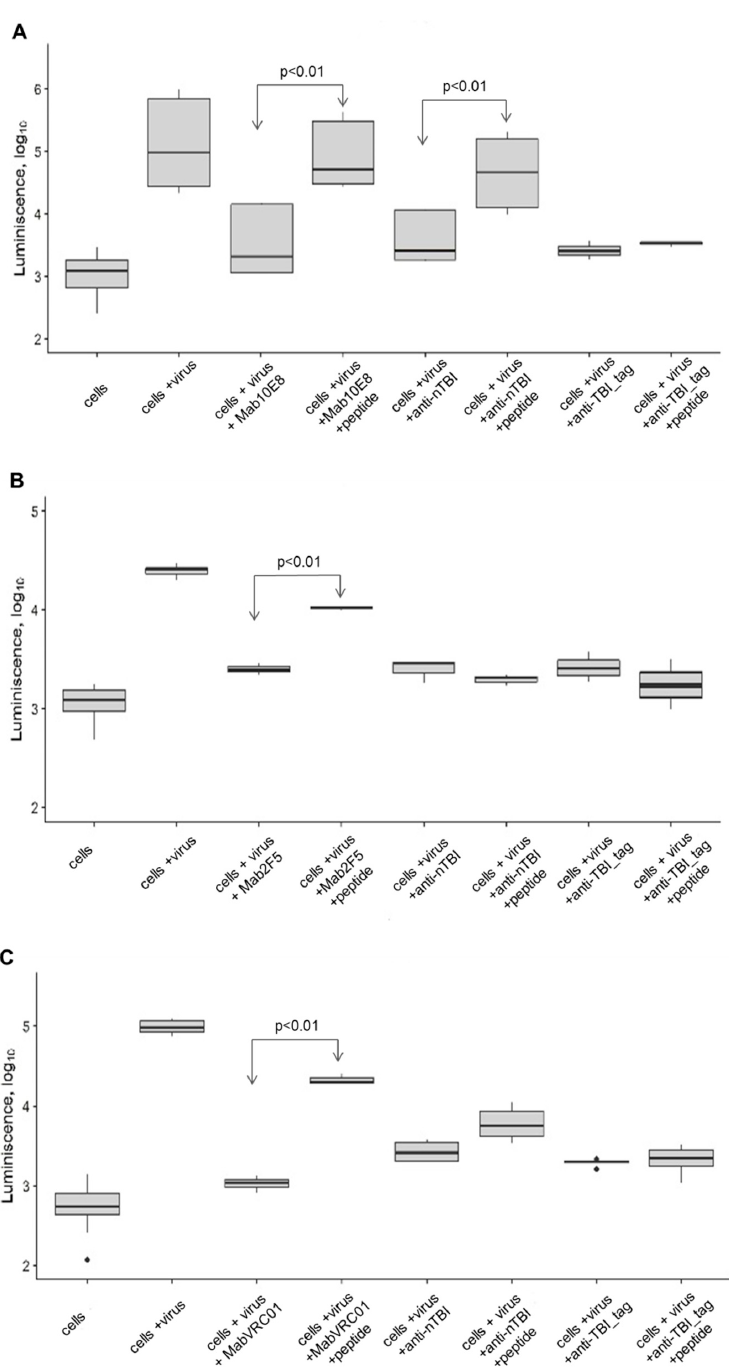
Figure 7. Inhibition of virus-neutralizing activity of antibodies by synthesized peptides: ( A ) 10E8 [NWFNITNWLWYIK], ( B ) 2F5 [NEQELLELDKWASLWNK], ( C ) VRC01 [VSWPELYKWTWS]. The following combinations were tested in the assay: cell + virus; cell + virus + monoclonal mAb 10E8 or 2F5, or VRC01; cell + virus + monoclonal mAb 10E8 or 2F5, or VRC01 + corresponding synthetic peptide; cell + virus + anti-nTBI IgG; cell + virus + anti-nTBI IgG + synthetic peptide; cell + virus + anti-TBItag IgG; cell + virus + anti-TBItag IgG + synthetic peptide. Relative luminescence intensity is indicated on the Y-axis (log10 RLU). Statistical di ff erences between groups cell + virus + mAb 10E8, or 2F5, or VRC01 and cell + virus + mAb 10E8, or 2F5, or VRC01 + synthetic peptide is p < 0.01; statistical di ff erences between groups cell + virus + anti-nTBI IgG and cell + virus + anti-nTBI IgG + synthetic peptide is p <